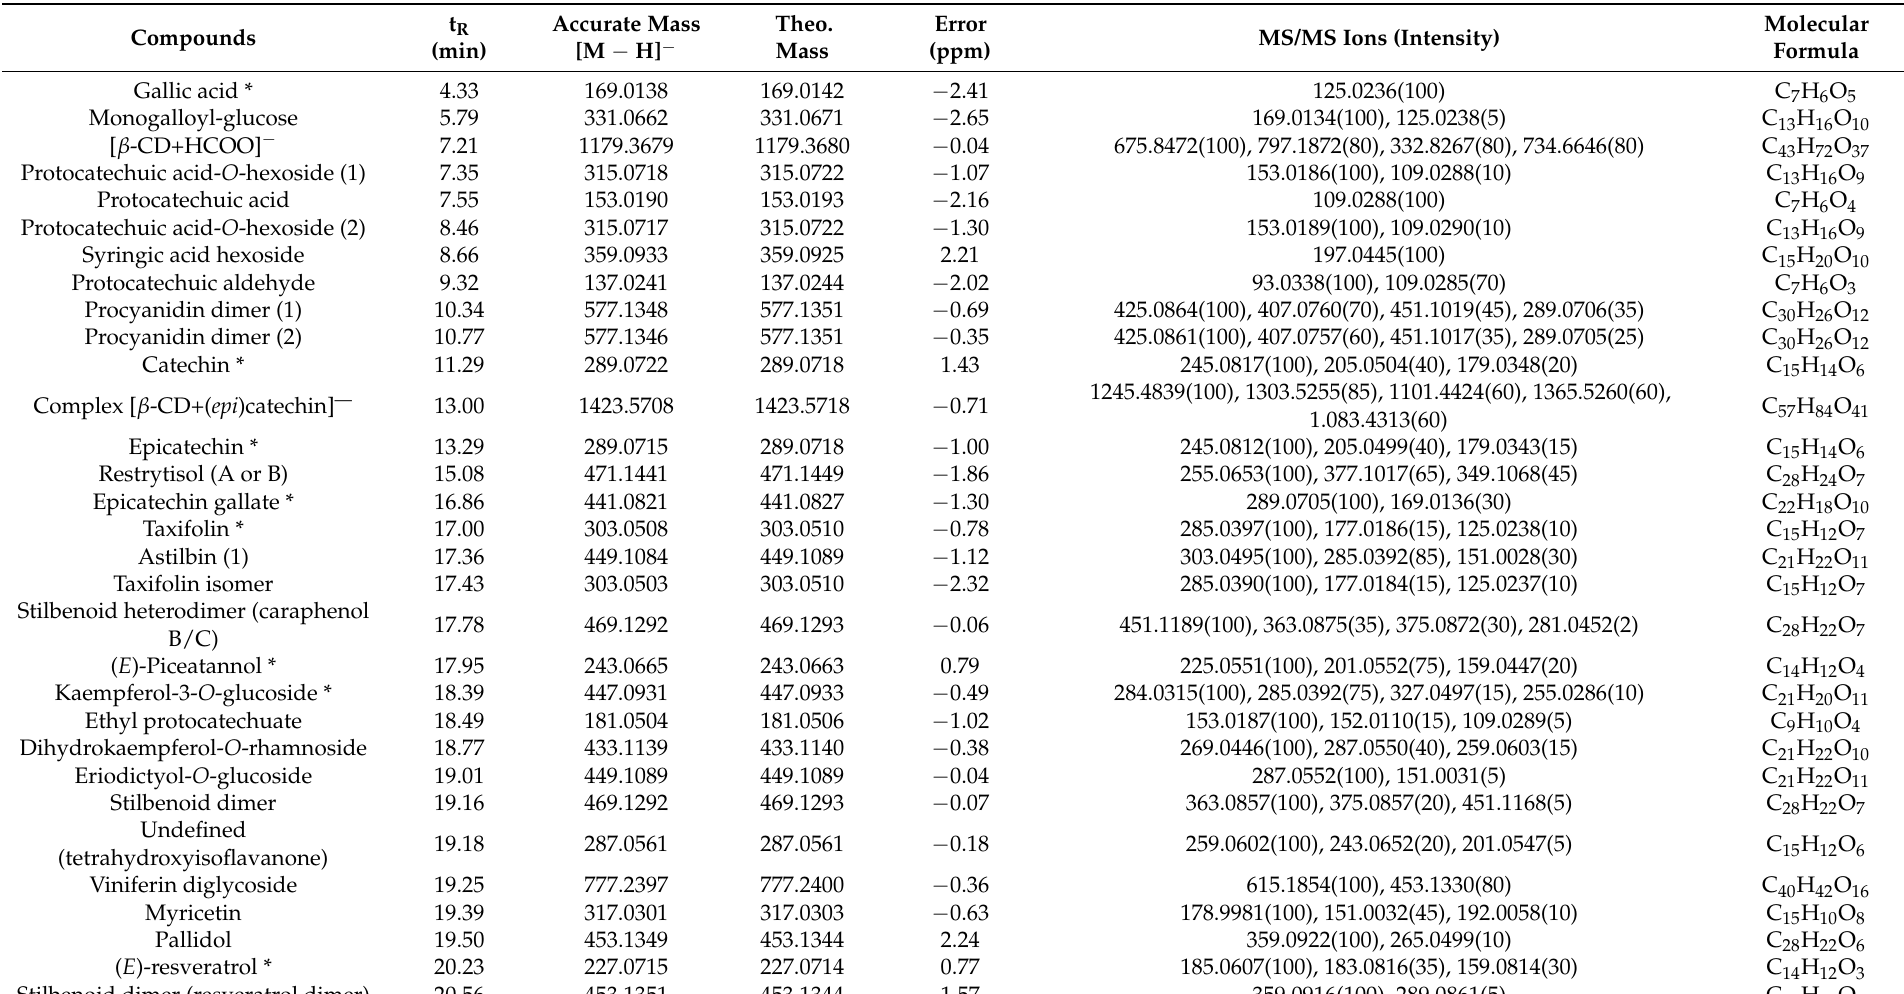
Table 2. Identification of phenolic compounds in the IC (GC PPE +HP- β -CD+MD), an adduct of β -CD and a complex between β -CD with ( epi )catechin using LC-ESI-LTQ-Orbitrap-MS in negative